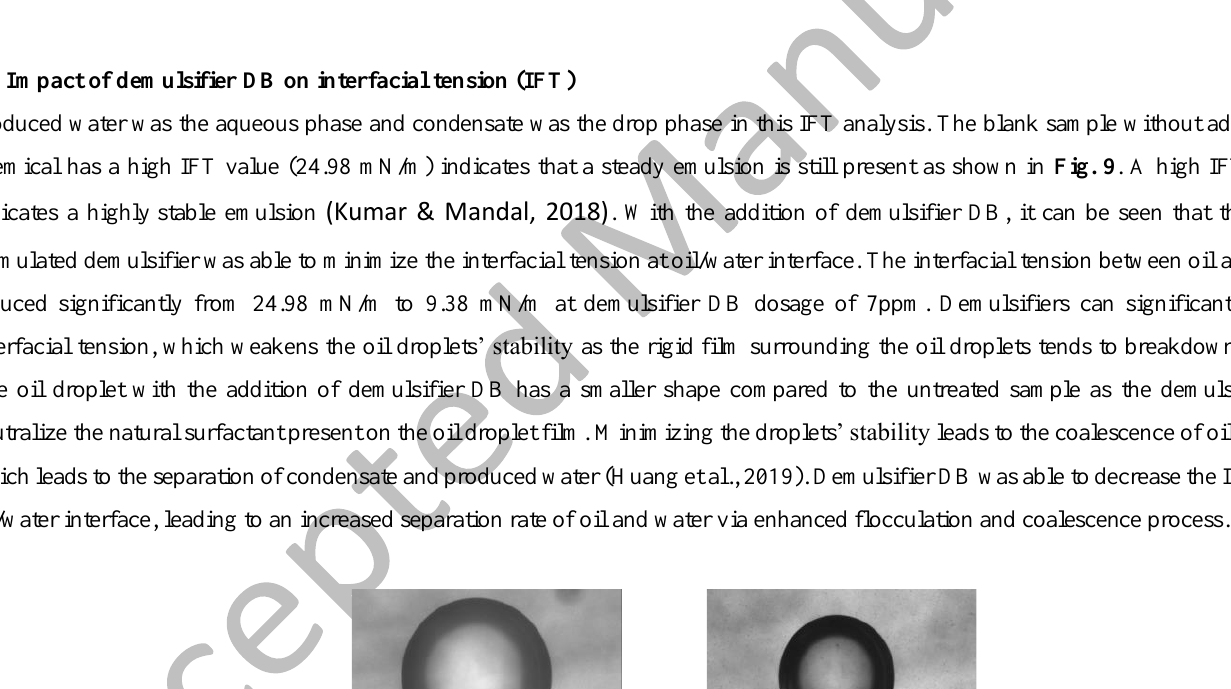
Fig. 8–Impact of demulsifier DB on the OiW content of treated produced water sample at 60 °C